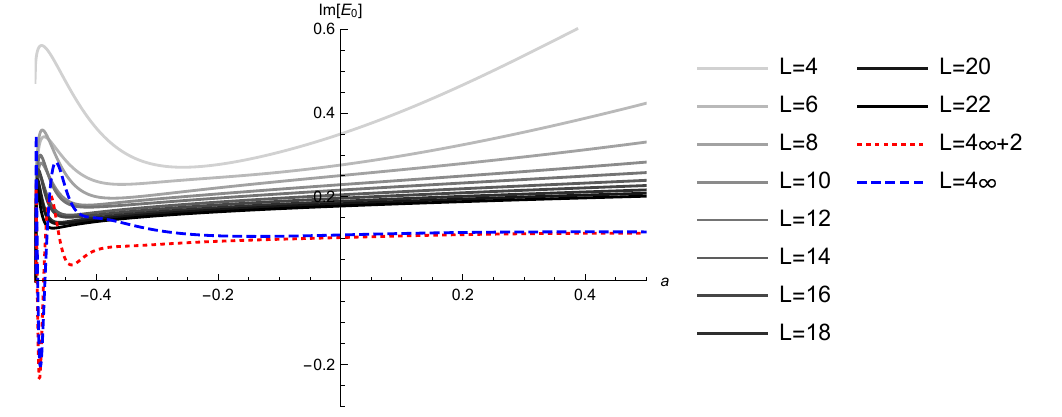
Figure 14 . Plots of the imaginary part of the gauge invariant observable E 0 (2.17) for the “ghost brane” solution Φ G at the truncation level L . The dotted and dashed lines are extrapolations to a L = 4 k + 2 ( k → ∞ ) and L = 4 k ( k → ∞ ), respectively. The horizontal axis denotes the value of the parameter a